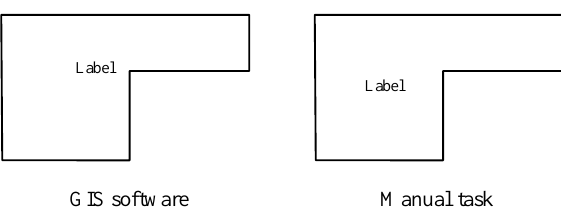
Figure 1. Label placement on the center of area-feature by GIS software and manual